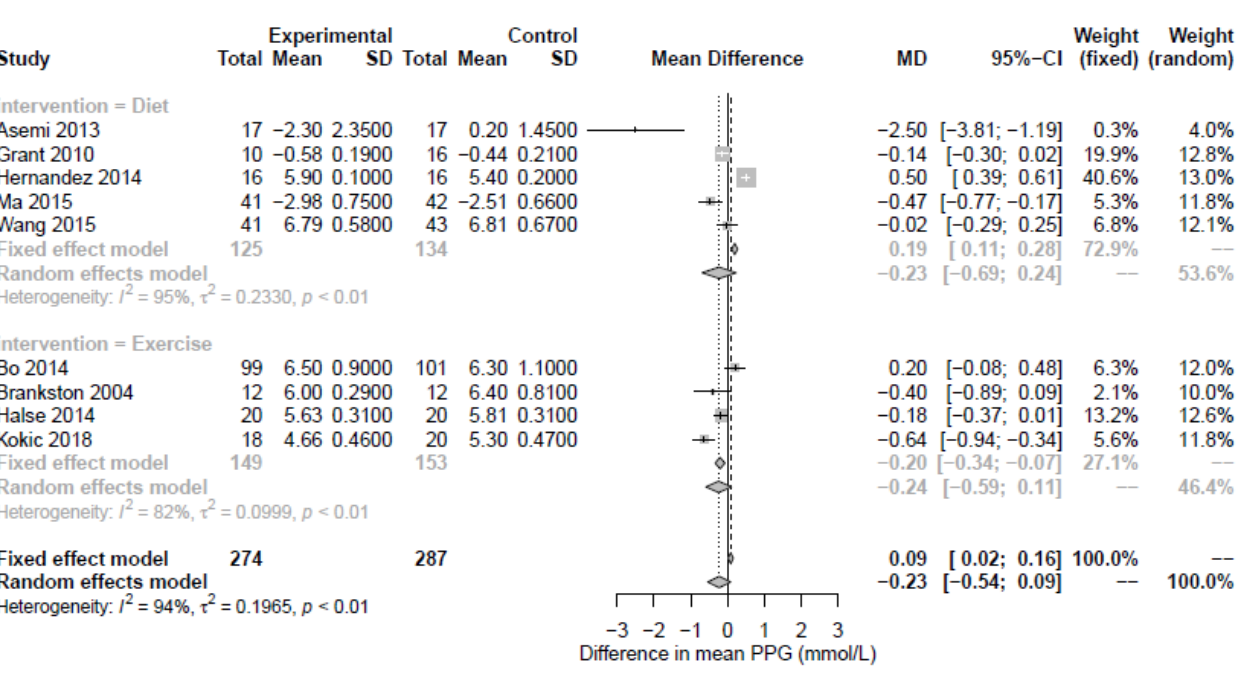
Figure 4. Forest plot of postprandial plasma glucose (mmol/L). Fixed and random-effect meta-analysis of included studies. Overall test for effect of any lifestyle intervention (with all studies; n = 23) and subgroup analysis by intervention type—nutritional supplements (n = 8), diet (n = 10), and exercise (n = 5)—are presented. SD, standard deviation; CI, confidence interval.